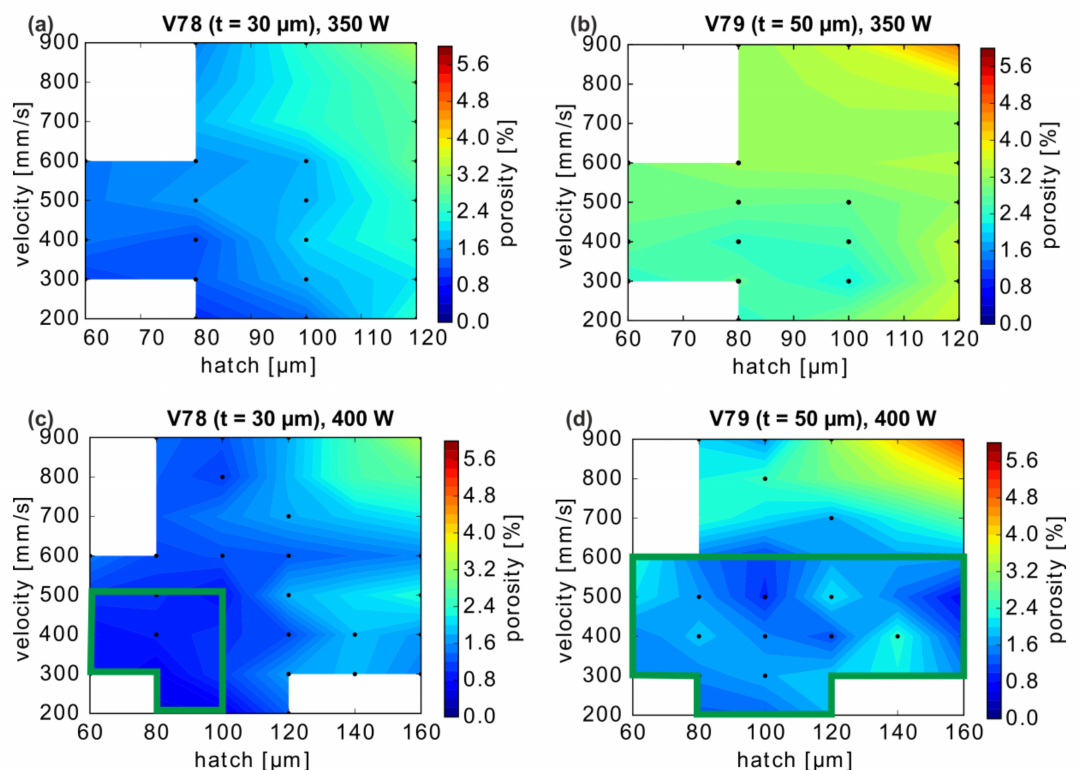
Figure 3. LPBF-CuCr1Zr-Porosity dependence on layer thickness t, laser power, velocity, and hatch distance (linear interpolation of porosity between data points). ( a ) and ( c ) t = 30 µ m, ( b ) and ( d ) t = 50 µ m, for P = 350 W and 400 W, respectively. Because not all process parameter combinations were measured (i.e., white regions), the chosen combinations are marked with black dots. The green rectangle indicates a possible process window for a given laser power of 400 W for 2 di ff erent layer thicknesses